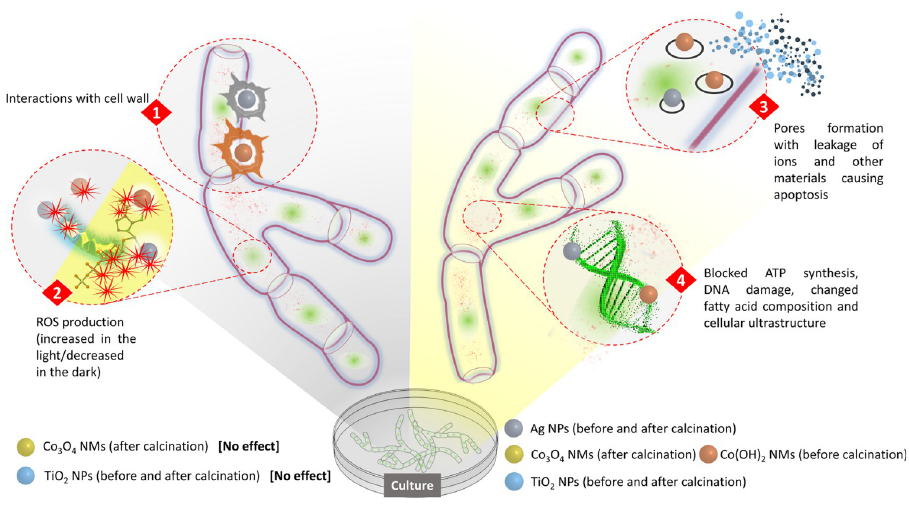
Fig 7. Hypothesized mechanism of NMs antifungal